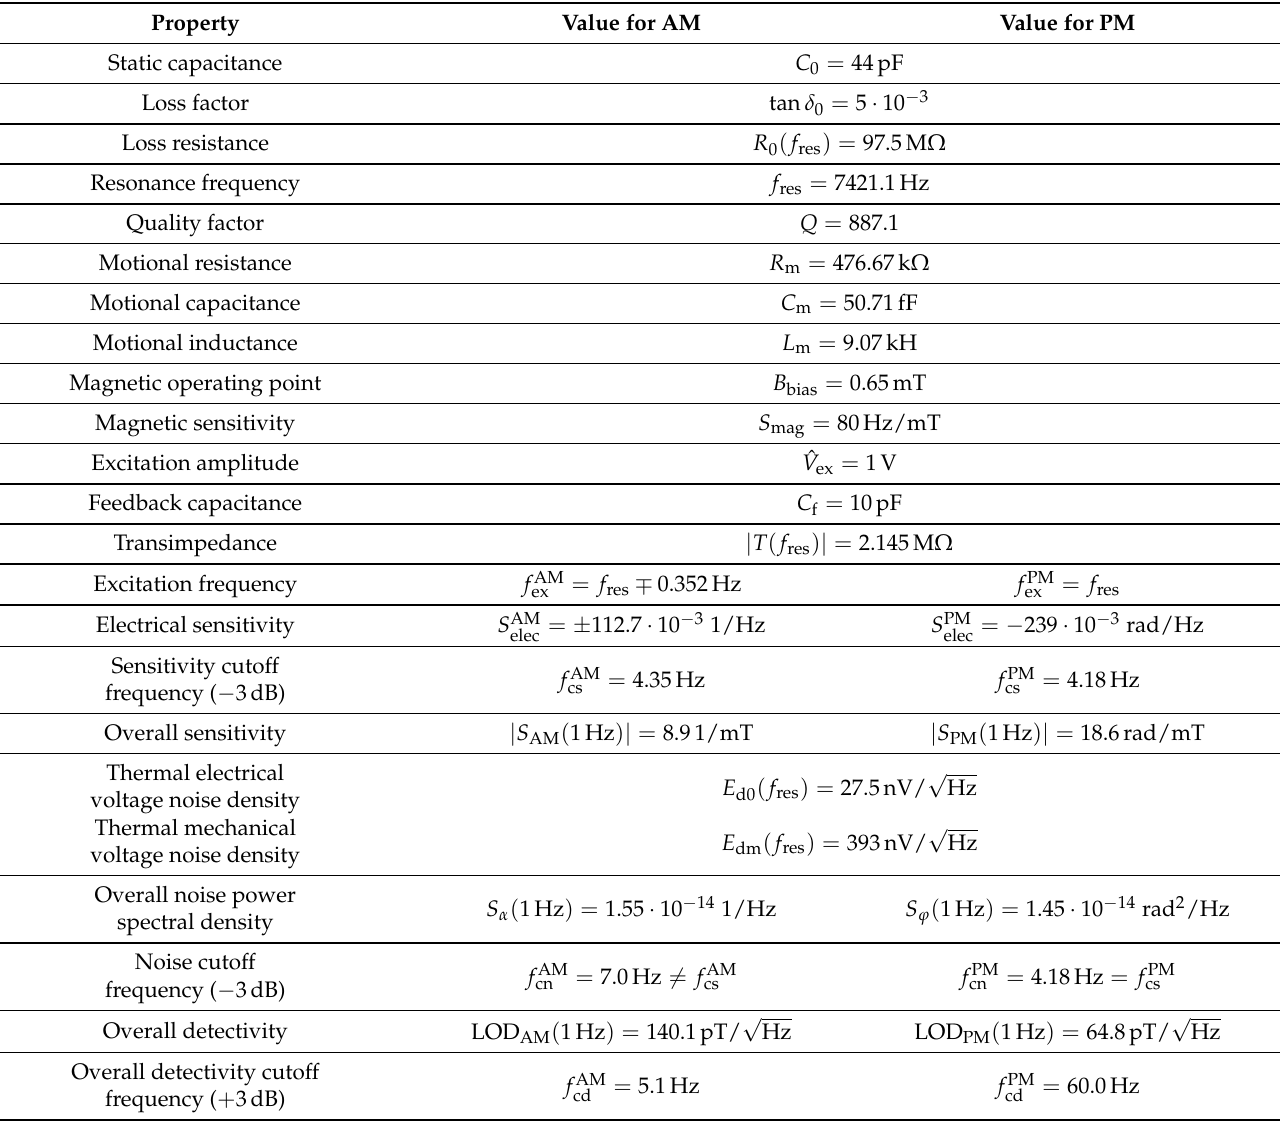
Table 2. Electromechanical properties of the exemplary magnetic field sensor referred to in this article and resulting numerical values for the derived